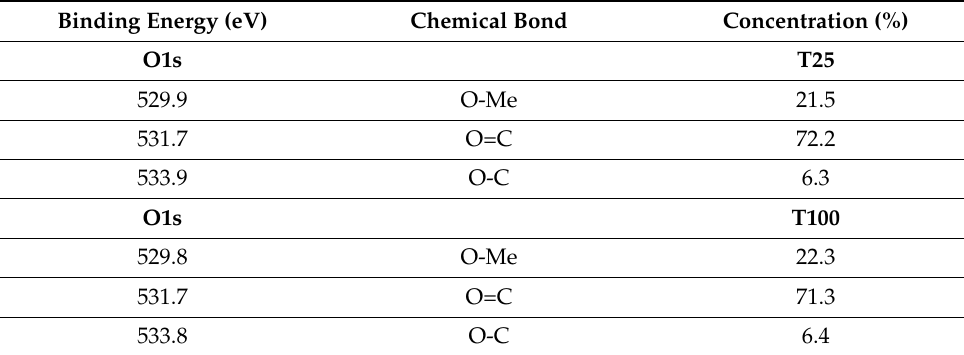
Table 3. XPS results of the deconvoluted components of O1s